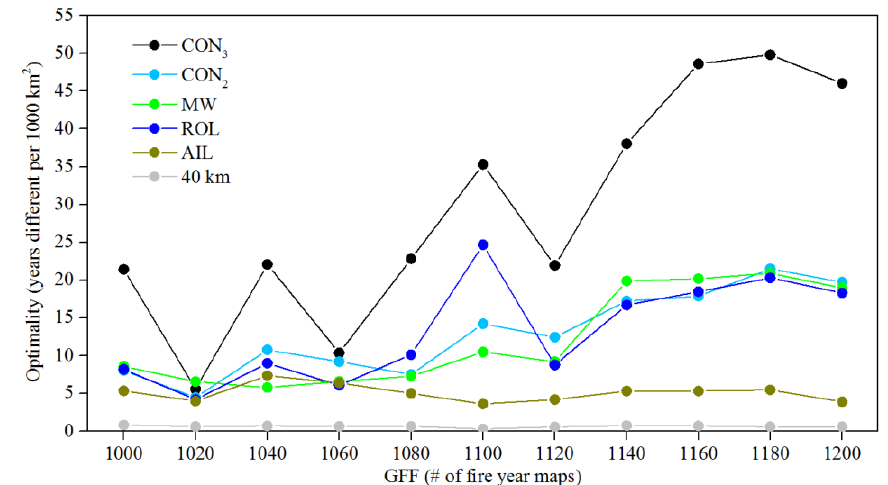
Figure 10. The optimality of the edge effected region (EER) with reduced fire frequency (RFF) detected in the 11 grid-level fire frequency (GFF) maps based on different numbers of fire-year maps. The EER with RFF was detected by six methods: moving windows (MW), agglomeration of inner lines (AIL), removal of outer lines (ROL), a 40 km buffer, and consensus EER of at least two (CON2) or all three (CON3) of the MW, AIL and ROL methods. Optimality was calculated as: (FR edge –FR interior ) divided by the size of EER in 1000 km 2 , where FR is the fire